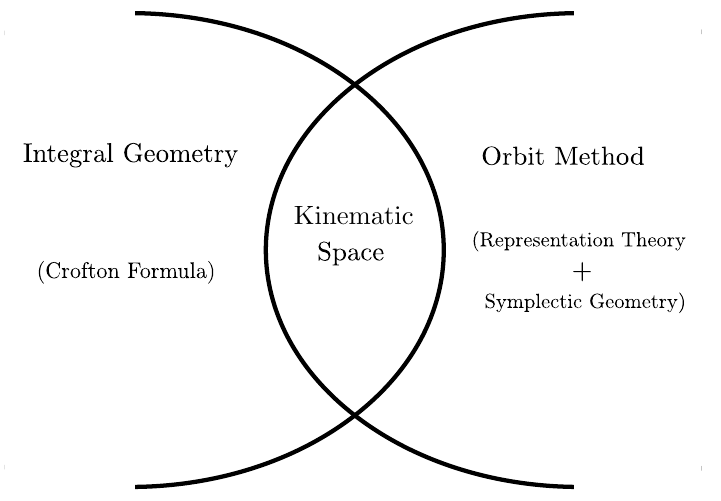
Figure 1 . Kinematic space has connections to two distinct branches of mathematics. The original motivation came from integral geometry. In this paper we point out a second connection to the orbit method, which lies at the crossover between representation theory and symplectic